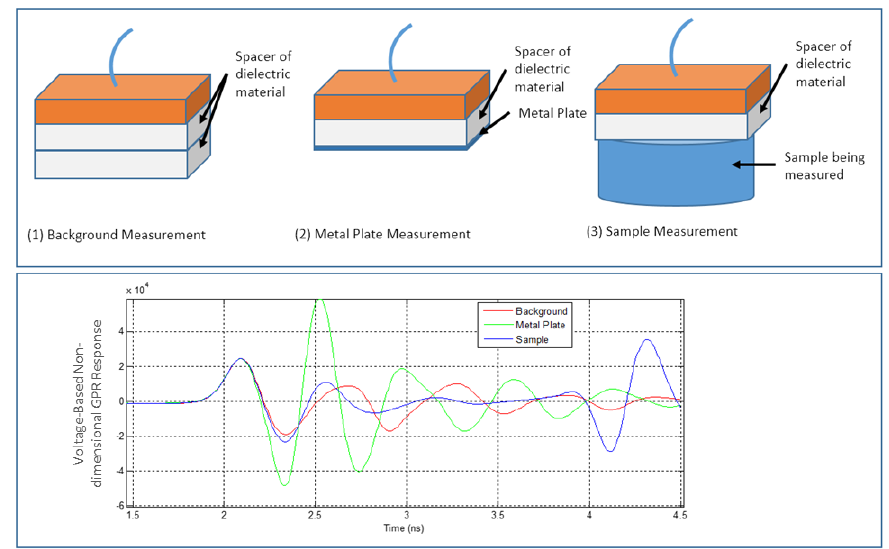
Figure 9. Three different measurement setups for surface dielectric ( top ) and examples of the corresponding scan data ( bottom ).